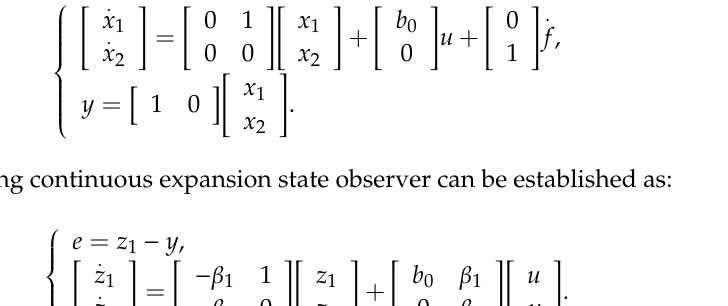
Figure 5. Structure of an active disturbance rejection controller (TD: tracking differentiator, NLSEF: nonlinear state error feedback, ESO: extended state observer).